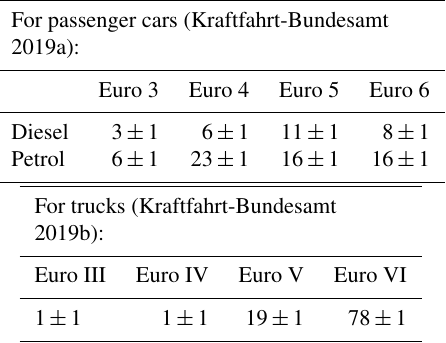
Table 3. Vehicle fleet composition by emission group in per cent. For passenger cars